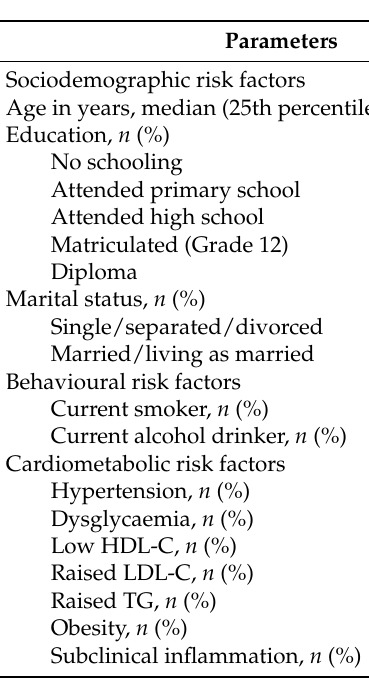
Table 2. Characteristics of the commercial taxi